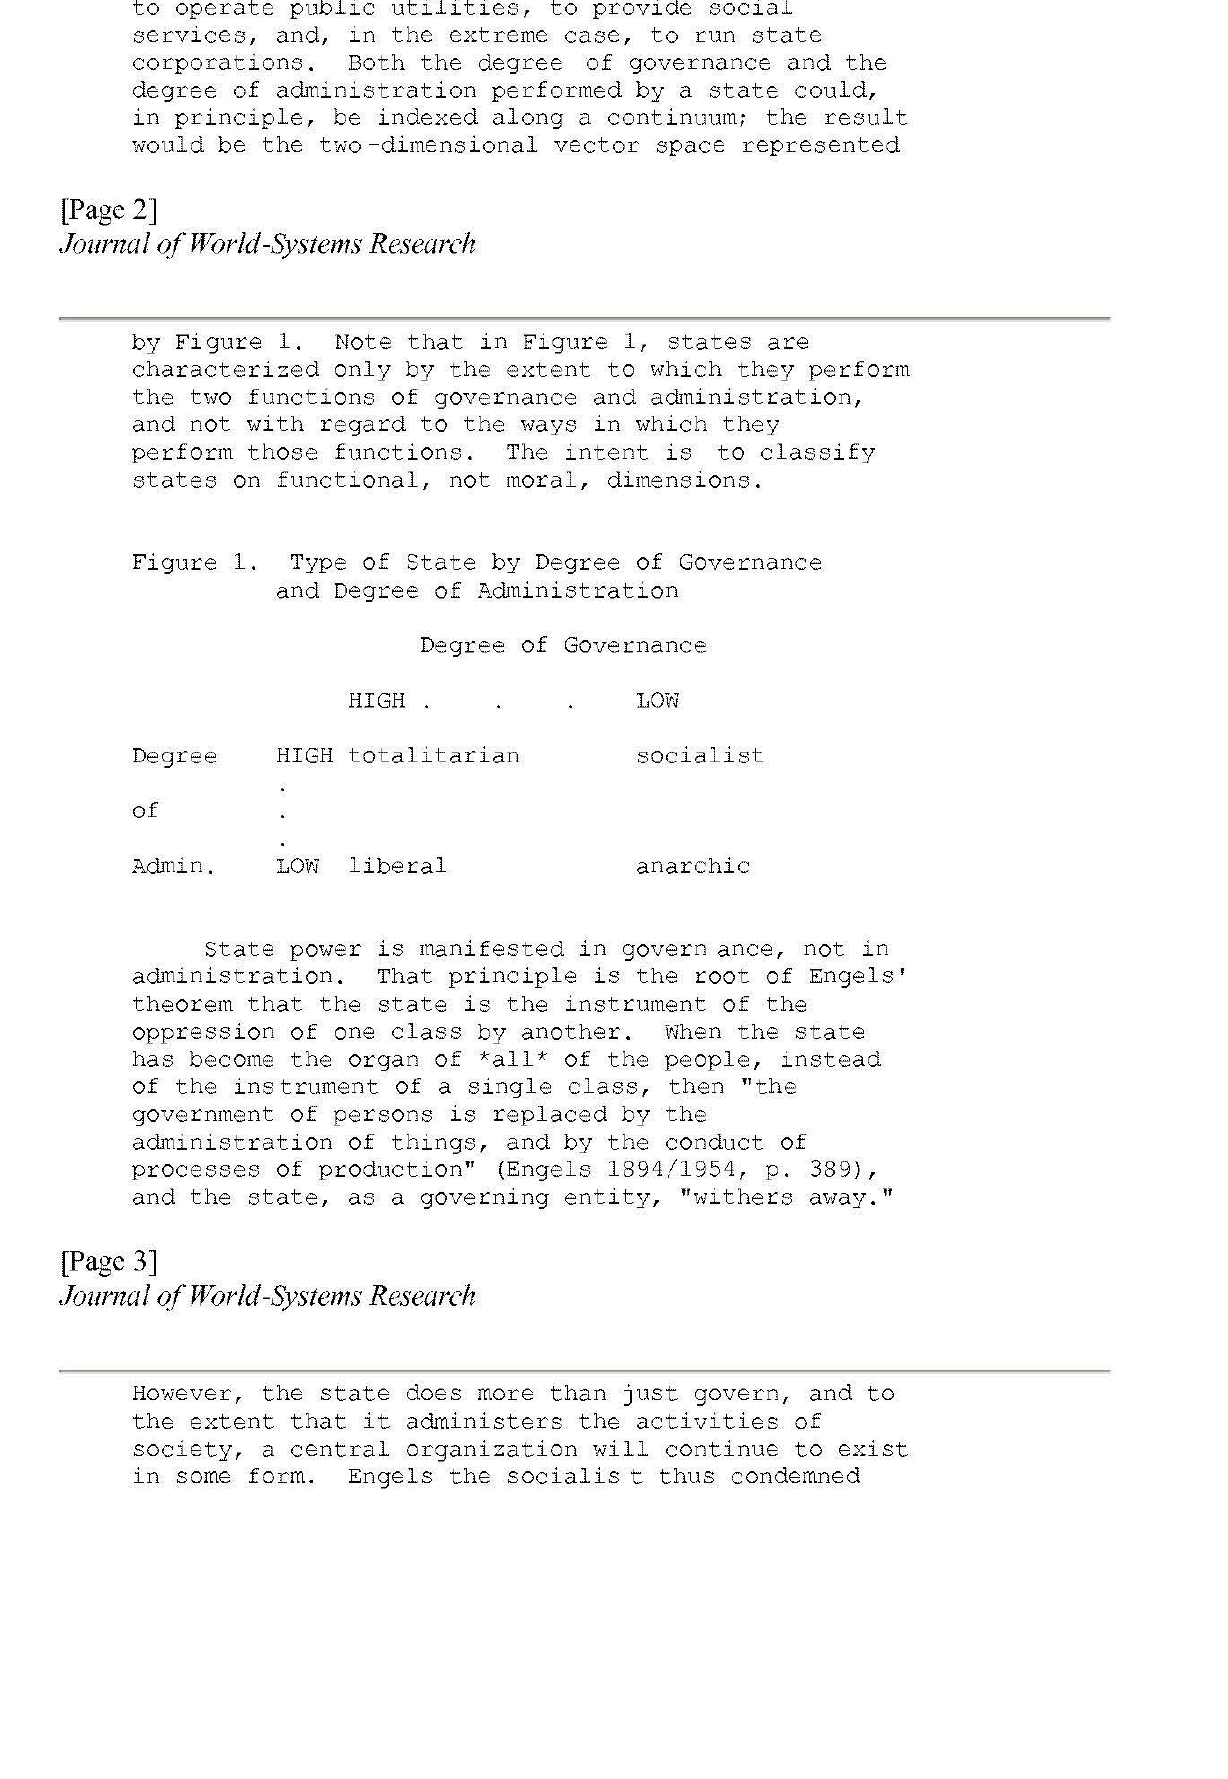
principle is the root of Eng e